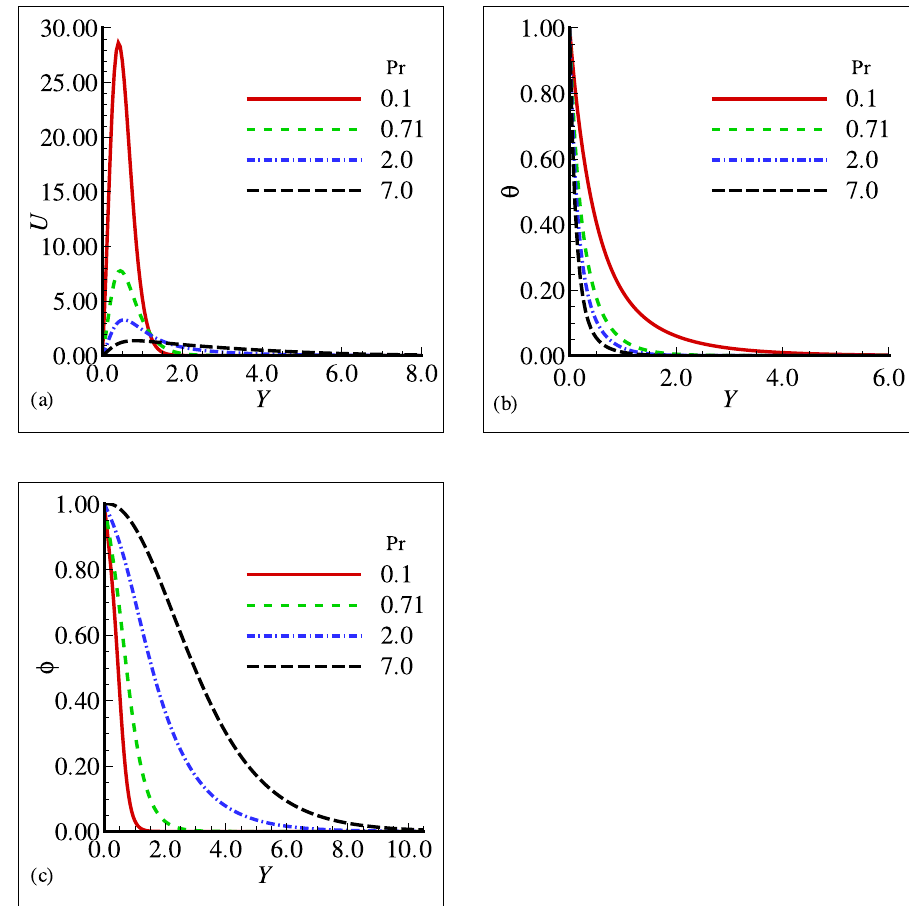
Fig 5. Profiles for (a) U (b) θ and (c) F for different Prandtl number Pr with n = 0.3, Sc = 0.8, E = 0.1, β = 0.2, γ = 0.5, λ = 0.5, ξ = 0.2 and γ μ =